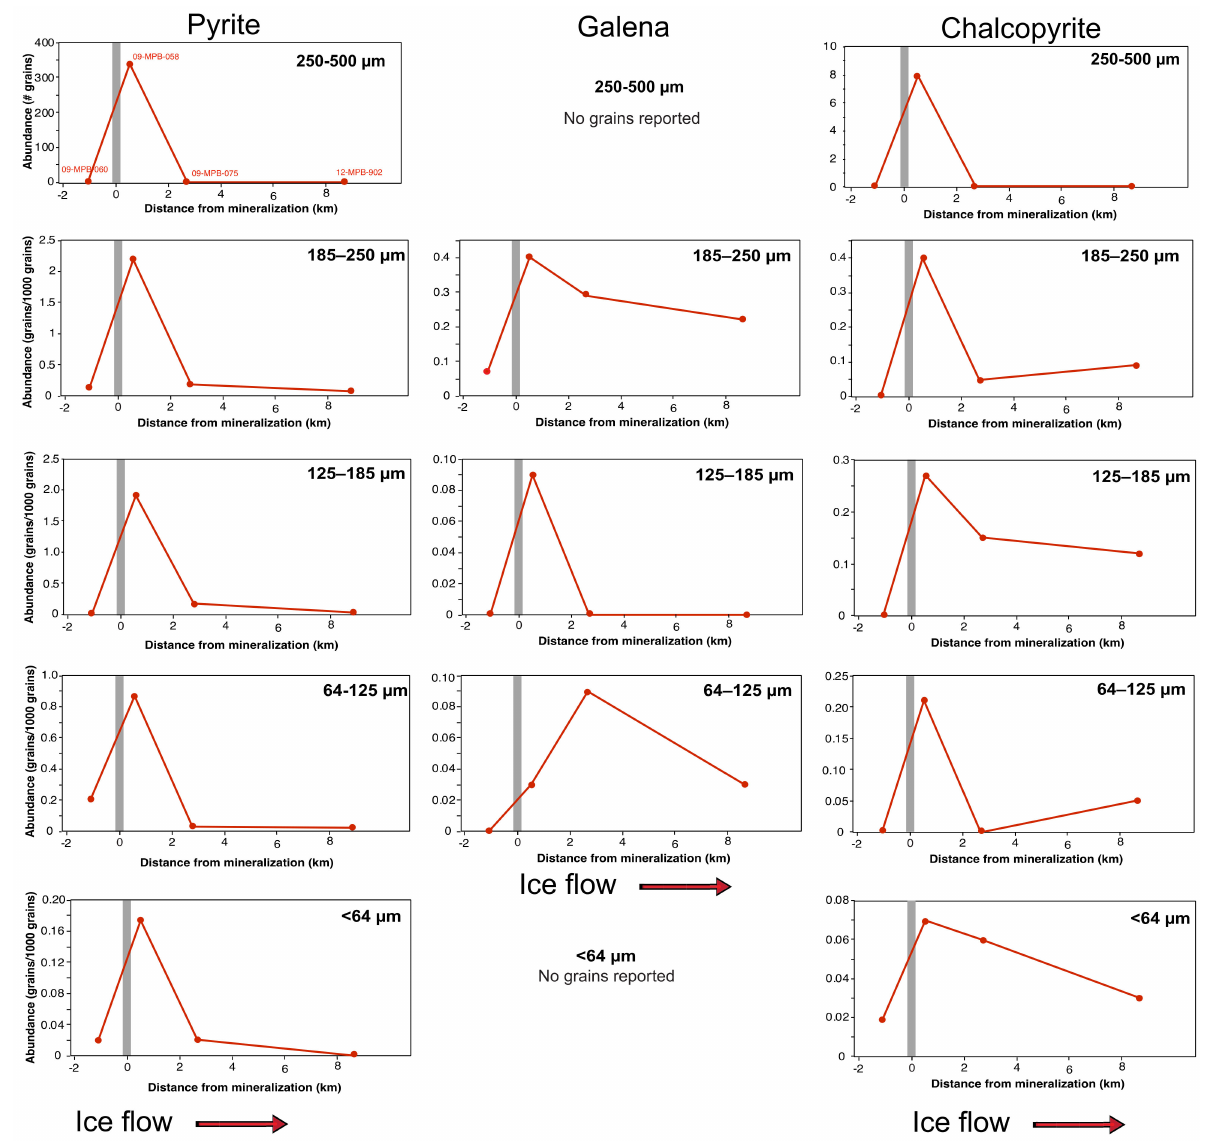
Figure 11. Lines plots comparing the abundance of pyrite, galena, and chalcopyrite grains in 5 different size fractions of heavy mineral concentrates (HMC) from till samples up and down ice of the Izok Lake VMS deposit. Location of mineralization is indicated by grey vertical line in each plot. Uppermost plots (250–500 µ m) represent grain abundance/10 kg determined by visual inspection of the HMC. Lower 4 plots (<250 µ m fractions) represent grains abundance/1000 grains determined by MLA. Modified from Lougheed et al. (2020)